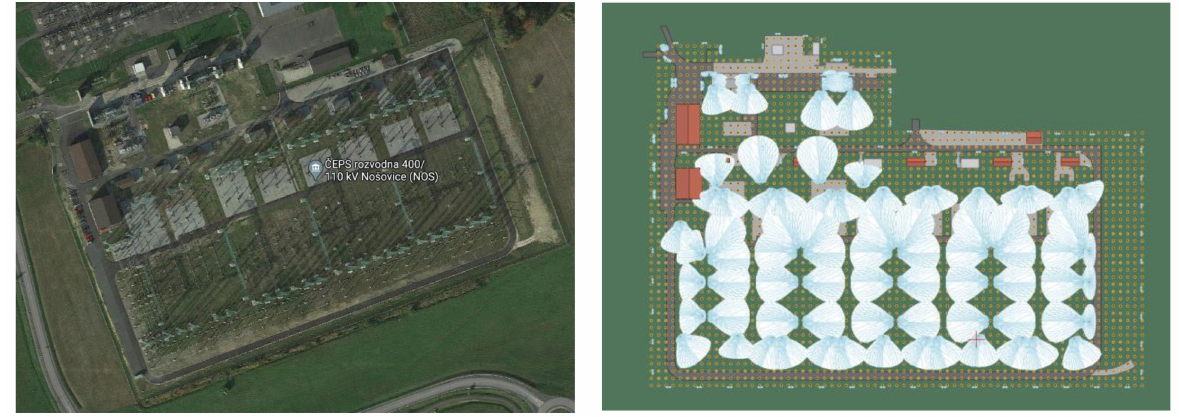
Figure 6. Layout of the electrical substation TR Nošovice; the area for modelling is marked. Table 3. Key parameters of the model of new lighting installation in TR Nošovice after refurbishment. Total Installed Power of Total Installed Illuminance Status All Lighting Systems Luminous Flux of All E 0 [lx] [kW] Light Sources [klm] All lighting 61.0 8068 67.0